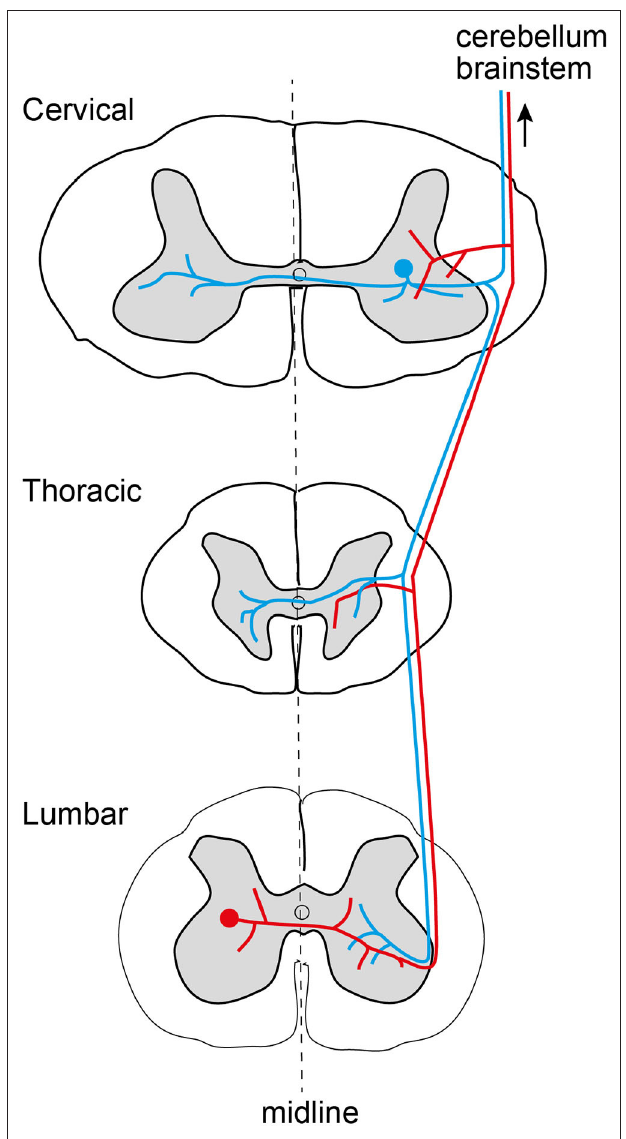
FIGURE 2 | Existence of individual spinal interneurons (red and blue) with extremely divergent axons, spanning multiple spinal cord segments, for both upper and lower limbs, uni- or bilaterally, as well as trunk muscles. In this example, one interneuron has its cell body in segment C7 (blue, upper body), and one interneuron has its cell body in segment L5 (red, lower